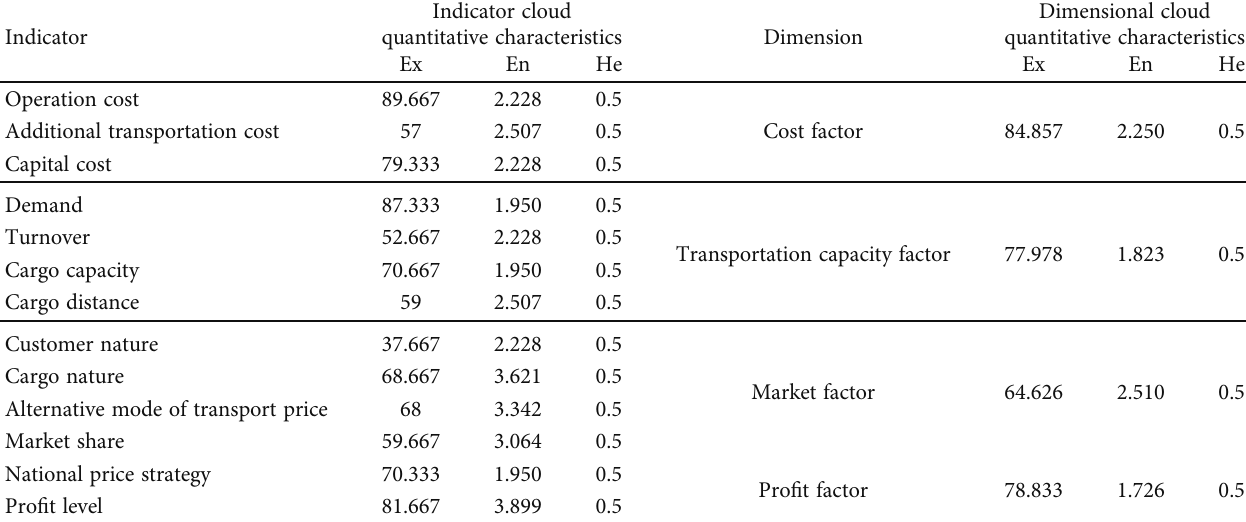
Table 9: Importance evaluation results of cloud quantitative